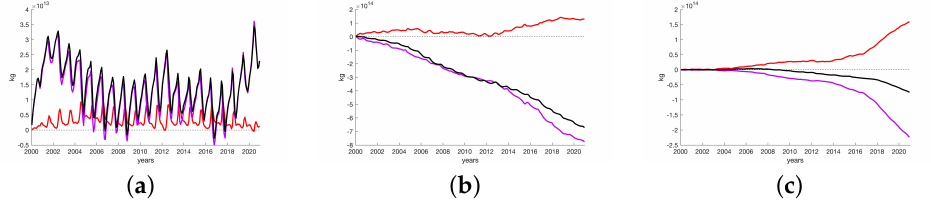
Figure 12. Timeseries of difference in mass (black curves), heat (red curves), and salt (magenta curves) content in terms of the increment in the mass of water in the Arctic (above 65 N): ( a ) upper 30 m layer, ( b ) 30–600 m layer, ( c ) layer from 600 m to bottom in terms of incremental values in numerical experiment B to experiment